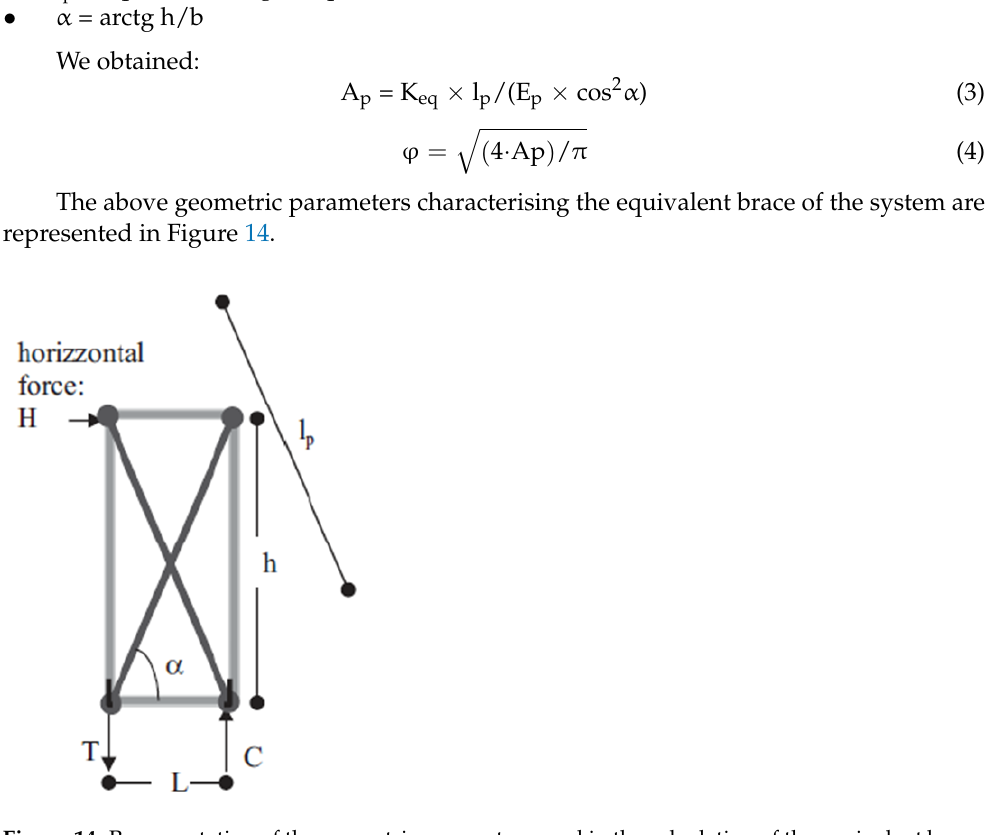
Figure 14. Representation of the geometric parameters used in the calculation of the equivalent brace. In Figure 15 there are all the façade fields (in orange) used for calculation of the Resisto 5.9 system and the corresponding equivalent diagonals (in